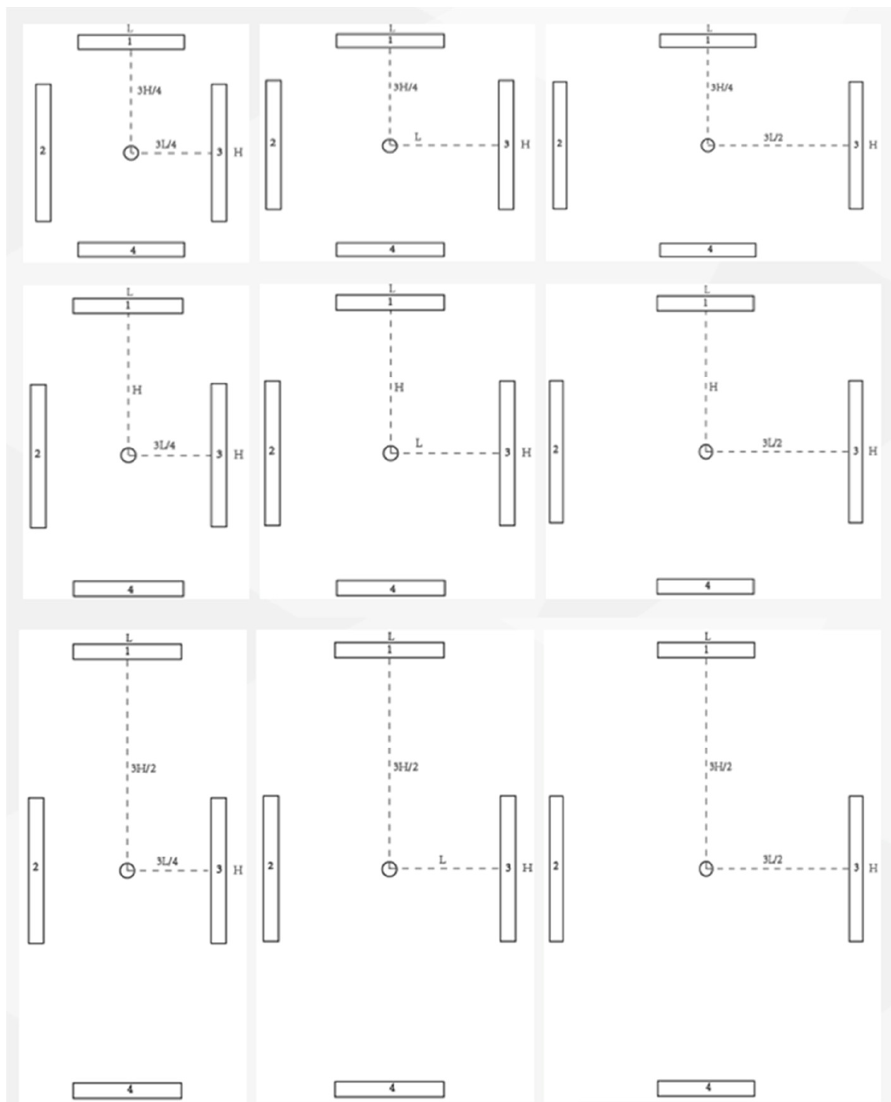
Figure 3. Layouts of vertical calibration scale belts: 3H/4, H, 3H/2 and layouts of horizontal calibration scale belts: 3L/4, L, 3L/2.